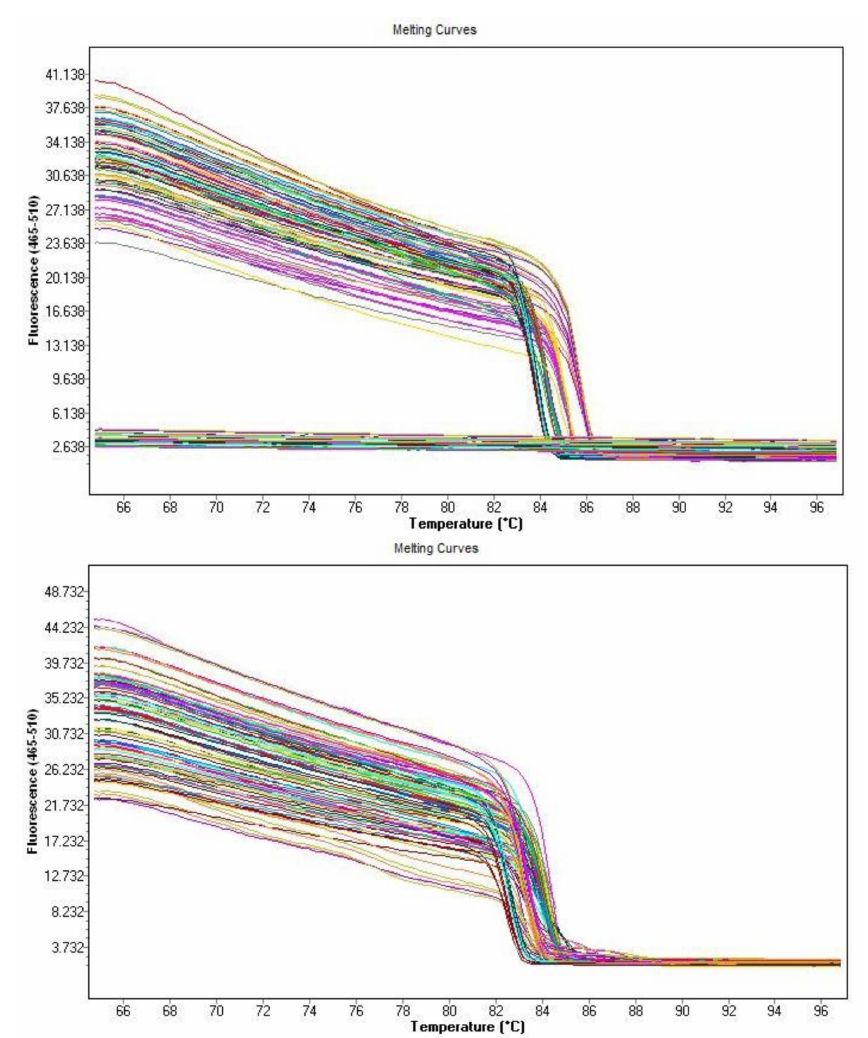
Figure A1. The melting curves of related genes ( SOD , POD , P5C , TOP6B , NCED3, RAD51 , XRCC3 and BRCA2 ) were analyzed via